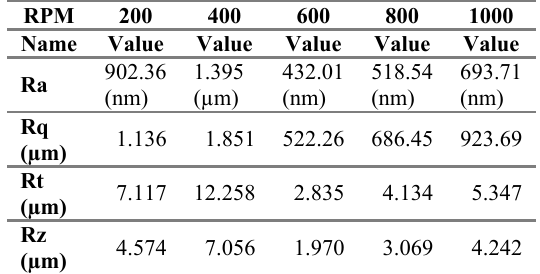
Table 2. Profile data for various